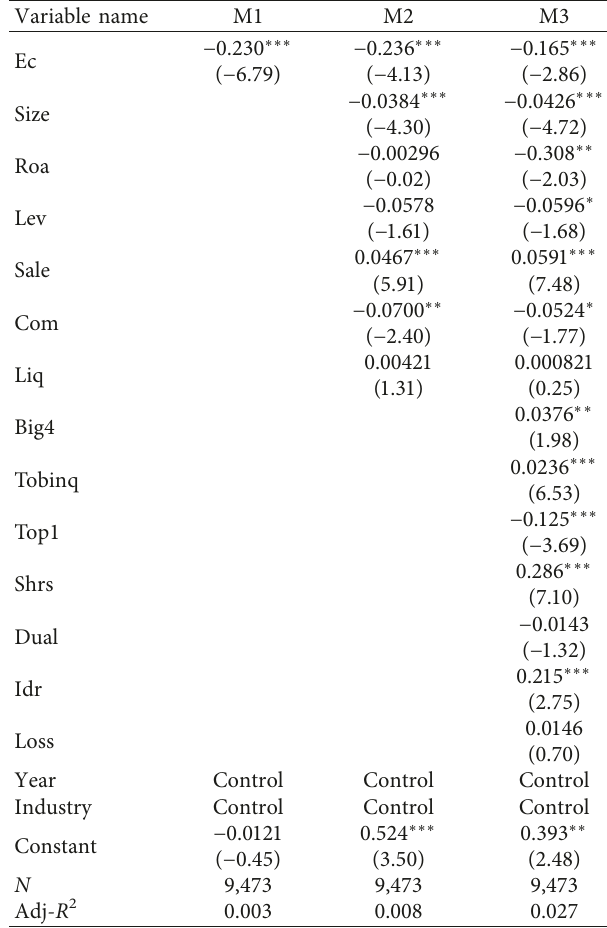
Table 3: OLS regression results of earnings persistence and ab- normal audit fees.